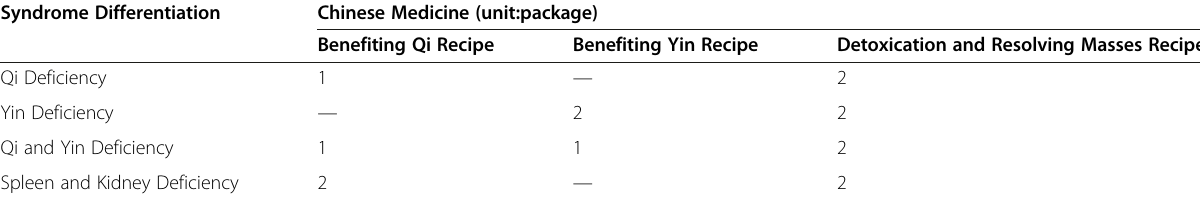
Table 1 Dosage of Chinese medicine according to different syndromes Syndrome Differentiation Chinese Medicine (unit:package) Benefiting Qi